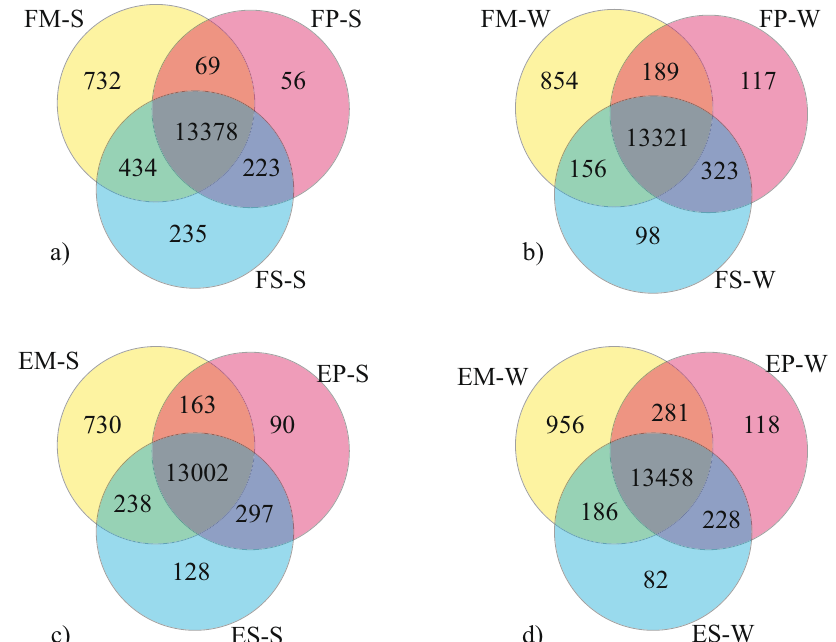
Fig. 1 Venn diagram showing overlap of expressed genes (CPM ≥ 0.5 for at least two samples) among tissues in each region and season. Shared and uniquely expressed genes across tissues (metacarpal M, perirenal P, and prescapular S) in a Finnish reindeer (F) in the spring (-S), b Finnish reindeer (F) in the winter (-W), c Even reindeer (E) in the spring (-S), and d Even reindeer (E) in the winter (-W).